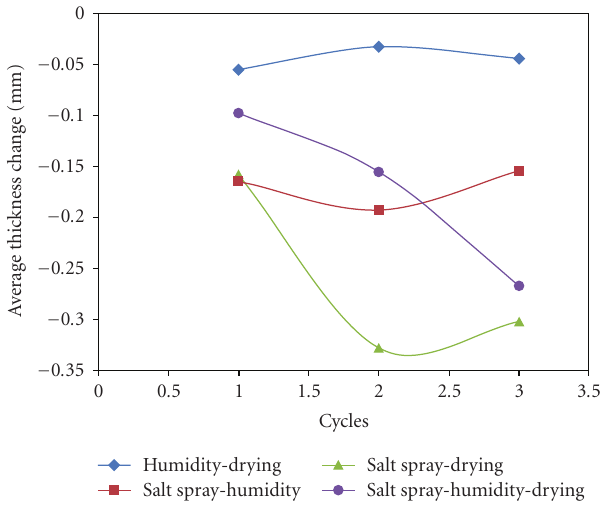
Figure 1: Average thickness loss of the AE44 coupons arranged by test condition based on cycle number. Note the almost parallel trend between the humidity-drying and the salt spray-humidity test conditions, as well as the almost parallel trend between the salt spray-drying and salt spray-humidity-drying test